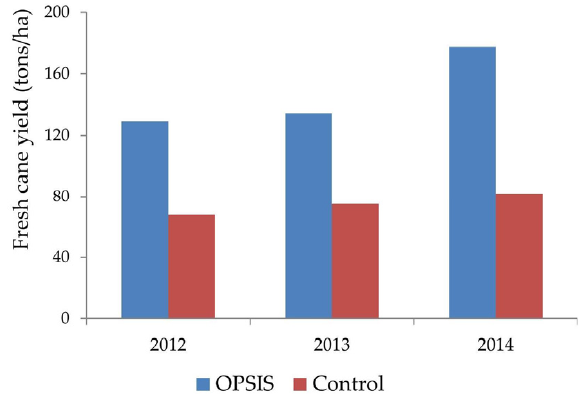
Figure 11. Fresh cane yield of sugarcane with OPSIS and rainfed condition.